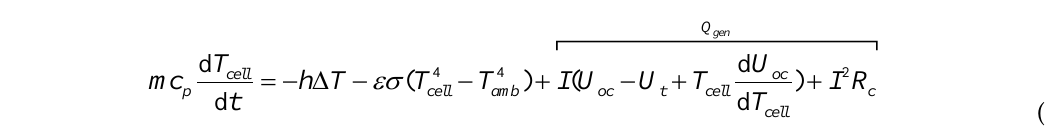
Table 1. Parameters values used in equations.